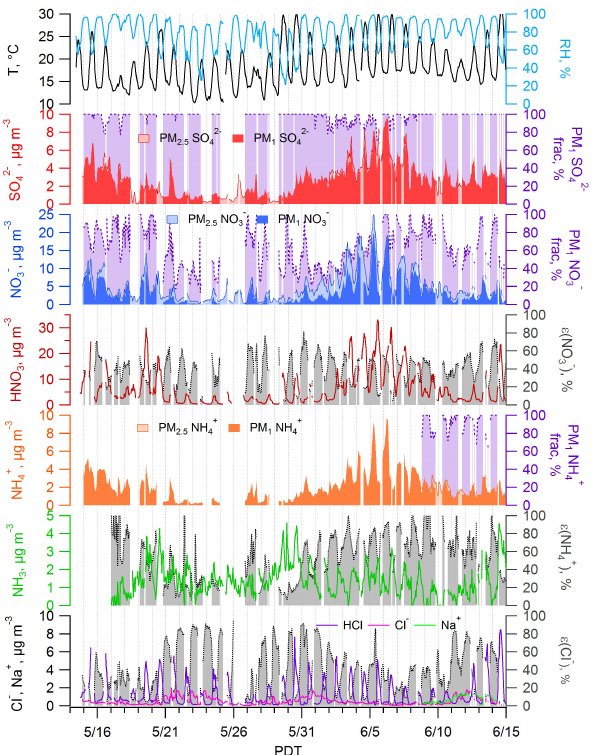
Figure 1. CalNex campaign time series of meteorological condi- tions ( T , RH), particle- and gas-phase inorganic compound mass loadings (SO 2 − , NO − , Cl − , NH + , Na + ; HNO 3 , NH 3 , HCl), 4 3 4 ) , particle-phase mass fractions of total (gas plus particle; ε (NO − 3 ε (NH + ) based on PM 1 and ε (Cl − ) based on PM 2 . 5 , all denoted by 4 grey shading), and PM 1 to PM 2 . 5 mass fractions of SO 2 − , NO − , 4 3 and NH + (all denoted by purple 4